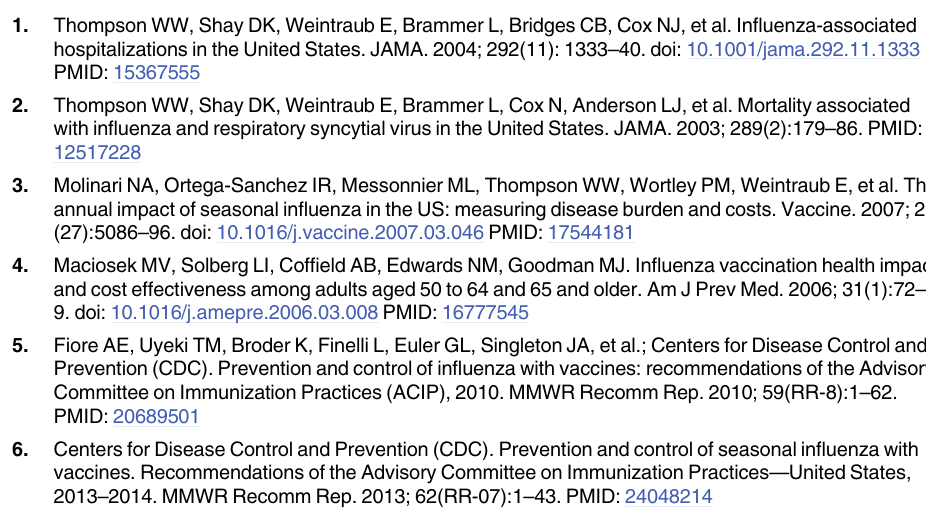
S1 Fig. Prevalence of influenza vaccination by age across racial and ethnic